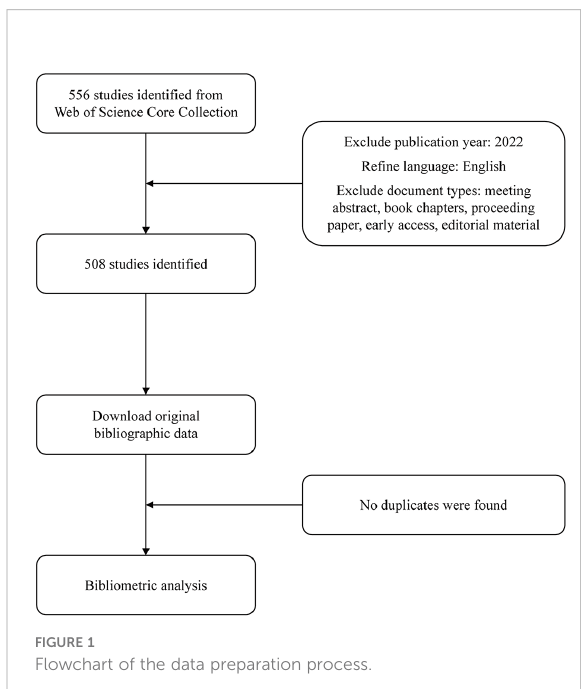
FIGURE 1 Flowchart of the data preparation